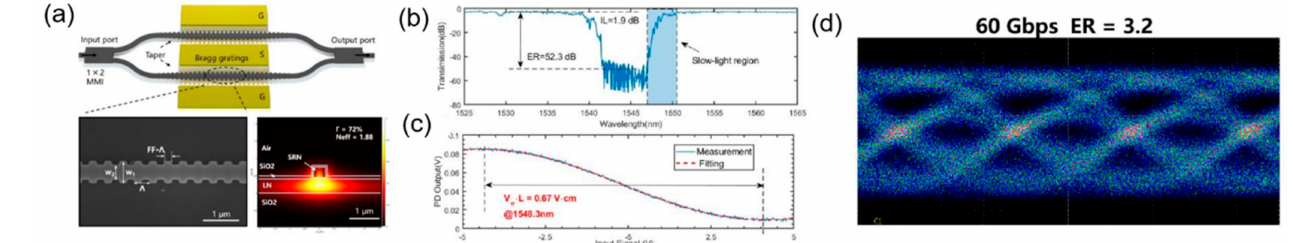
Figure 18. Silicon-based lithium niobate waveguide grating modulator. ( a ) Schematic and SEM of the thin-film lithium niobate modulator [77]. ( b ) Transmission spectra of the device with Bragg grating waveguides [77]. ( c ) Modulation response of the slow-light modulator [77]. ( d ) Eye diagram (60 Gb/s) of the slow-light modulator